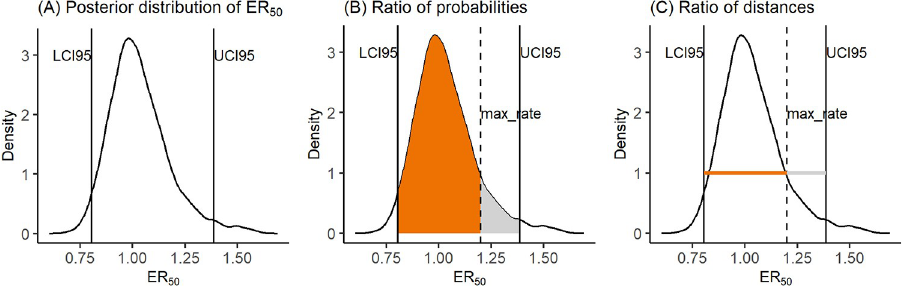
Fig 1. Example of posterior probability distribution of ER 50 (A) and calculation of both censoring criteria